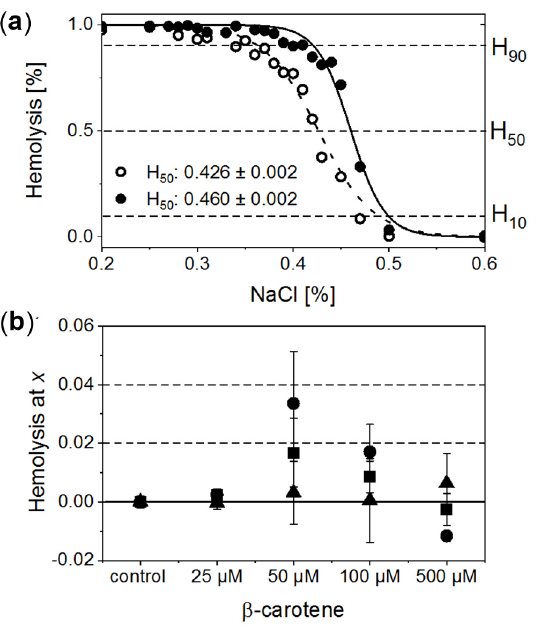
Figure 2. ( a ) Normalised exemplary osmotic fragility curves of RBCs incubated in the presence of 50 µ mol/L β -Crt (RBCs 50 , filled circles) accompanied by corresponding control (open circles). Inset: calculated respective H 50 values. ( b ) Evaluated H 10 (filled triangle), H 50 (filled square) and H 90 (filled circle) as a function of β -Crt concentration. In each case, the mean values from three independently conducted experiments are shown (three randomly selected blood donors). Errors of the values are calculated from the square of mean standard deviation of the mean average. Labels: H 10 , H 50 , H 90 –haemolysis at a level of 10%, 50% and 90%,